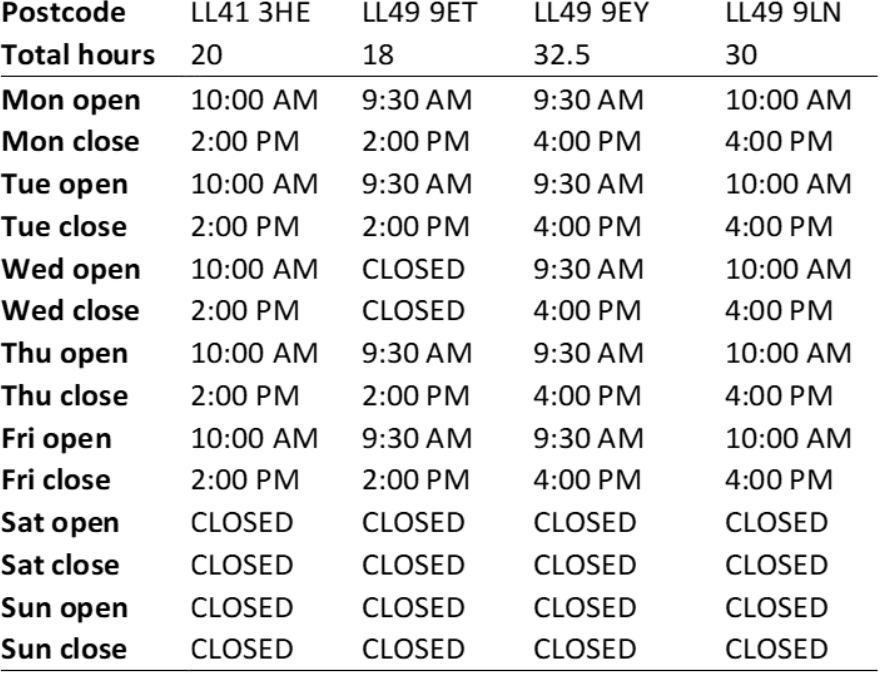
Figure 2. Temporal availability of branches. Opening and closing times vary amongst branches, and sometimes at the same branch between days. Few sites offer Saturday opening.